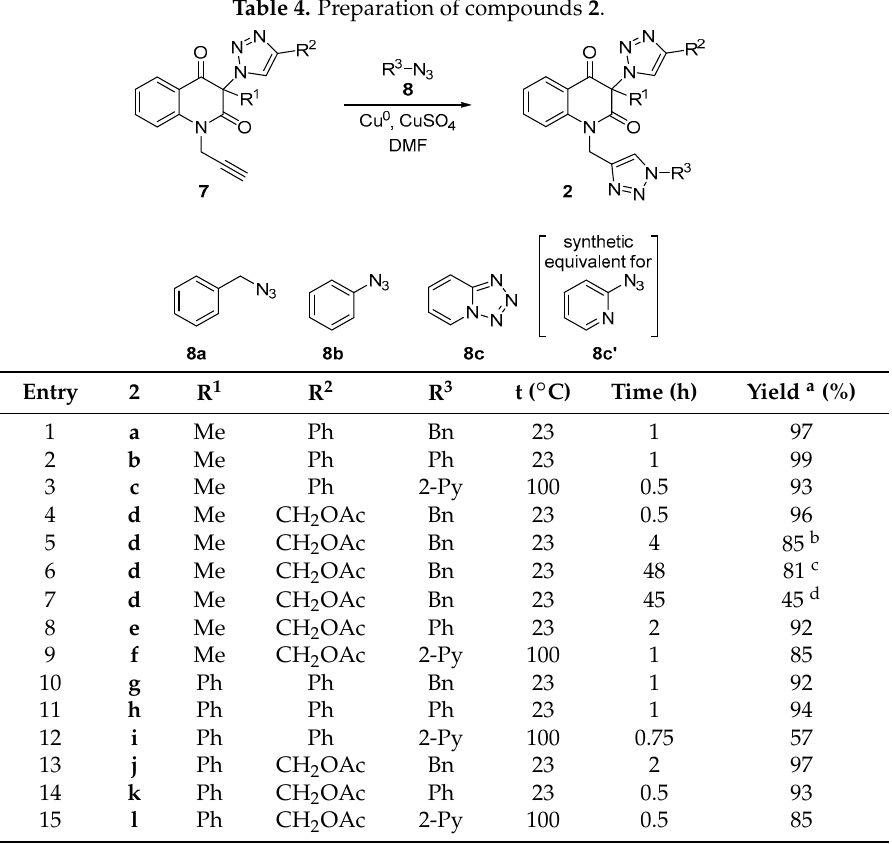
Table 4. Preparation of compounds 2 .